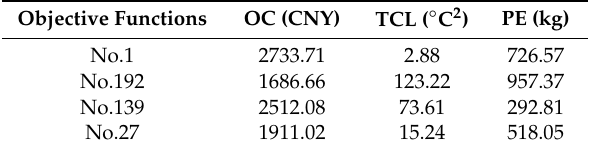
Table 14. Value of objective functions of different scheduling schemes for a typical day in summer. Objective Functions